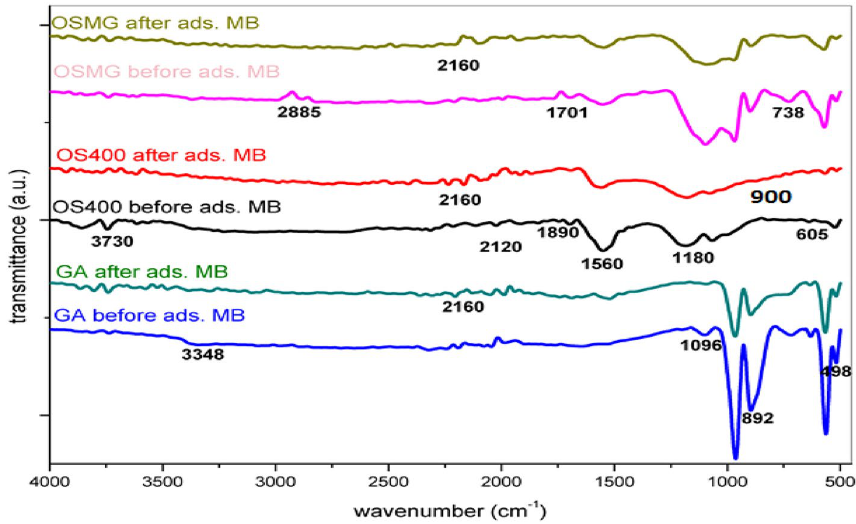
Figure 4. FT-IR spectra analysis of Garnet GA, OS400 and OSMG before and after adsorption of MB.